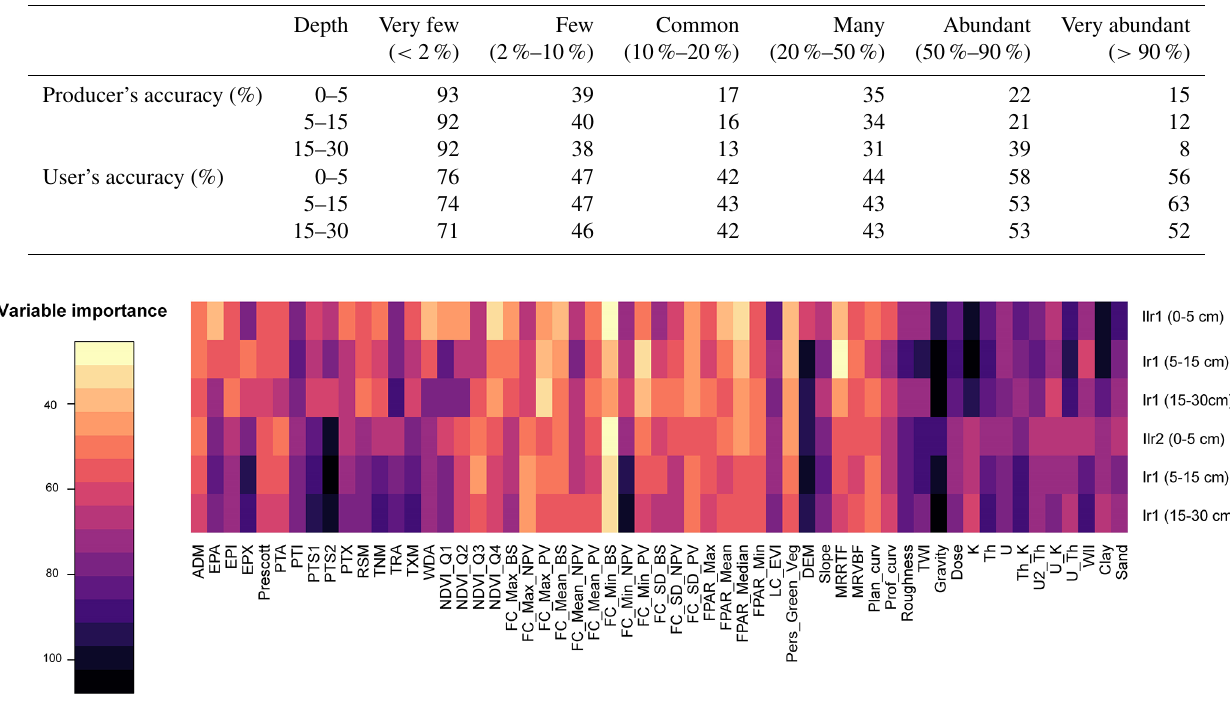
Figure 5. Variable importance of random forest models for predicting ilr-transformed SOC fractions. Variable importance was calculated from permutation as per Breiman